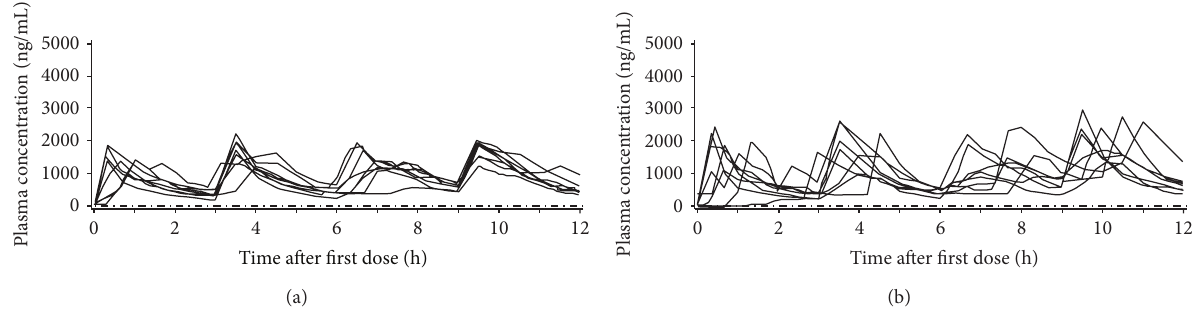
Figure 2: L-dopa plasma concentrations for patients in Cohort 2 (dose administration every 3 hours) receiving V1512 solution (a) or L- dopa/carbidopa 100/25mg standard-release tablets (b). All patients with data available for the pharmacokinetic analyses were included; patients with significant violations that may have invalidated or biased the results of the pharmacokinetic evaluations were excluded. – ⋅ – ⋅ – ⋅ = lower limit of quantification (10ng/mL).